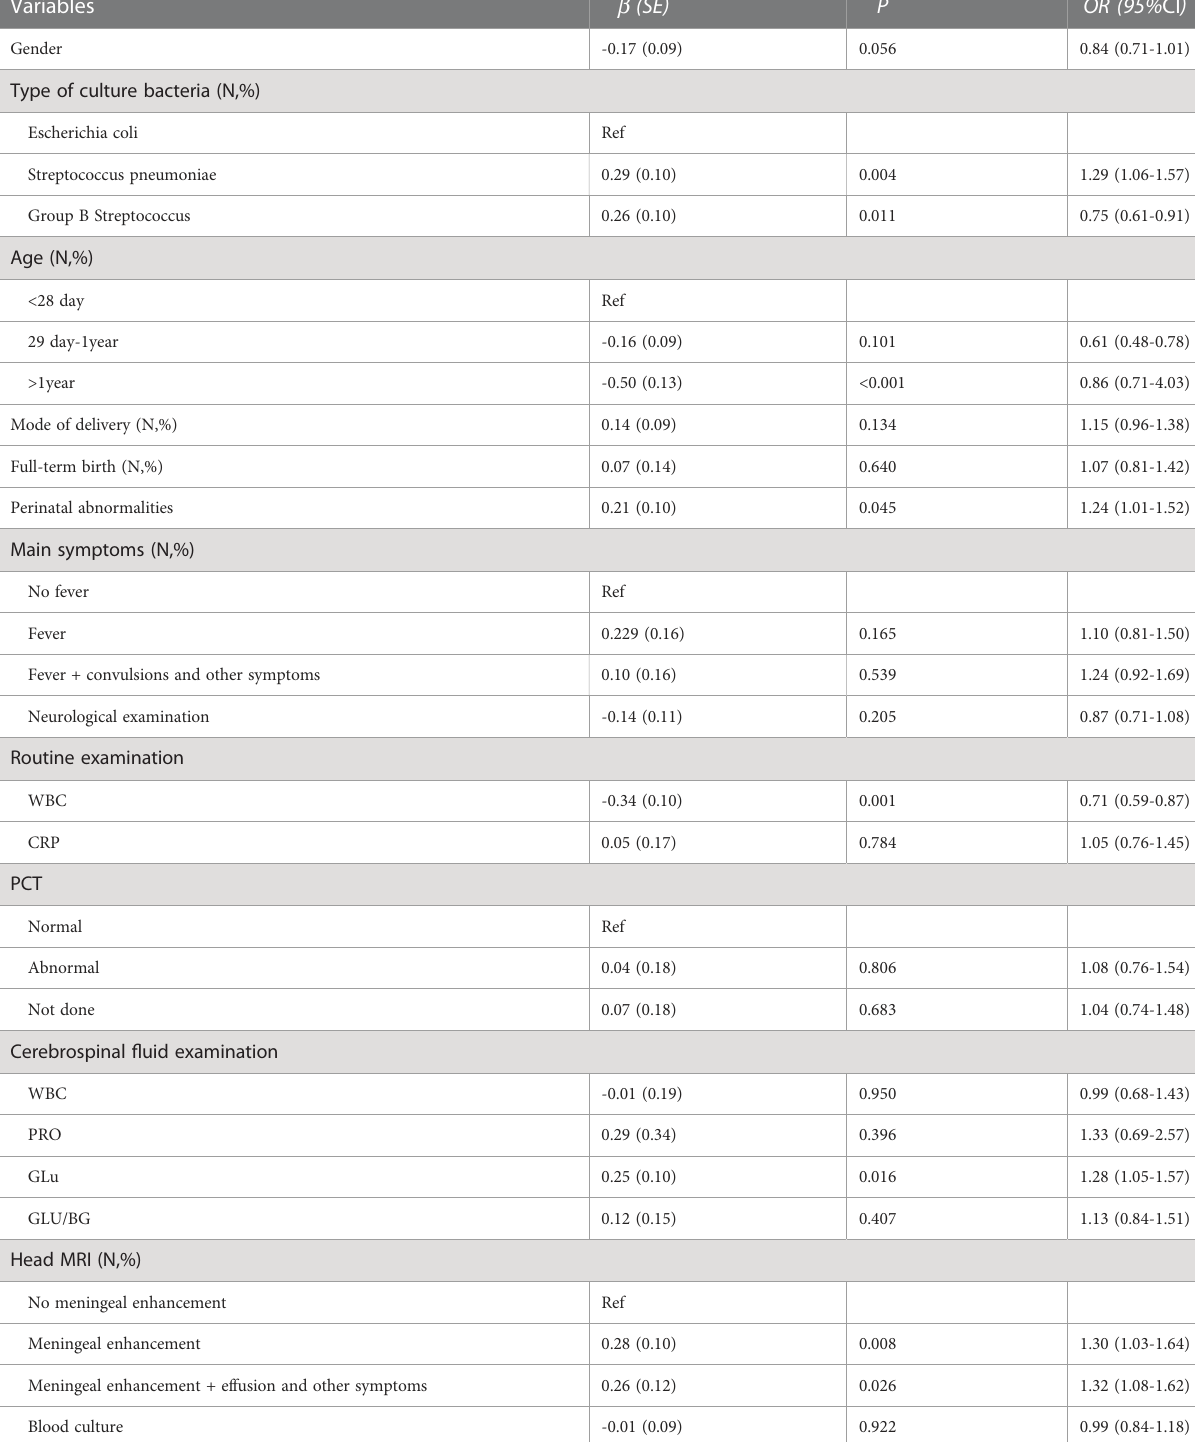
TABLE 4 Inivariate analysis of risk factors for length of hospitalization in children with